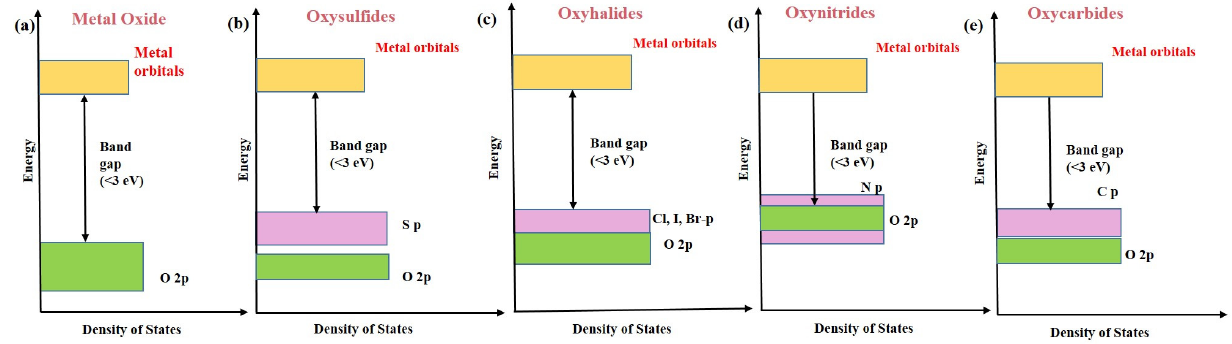
Figure 3. Comparison of the electronic structure of ( a ) metal oxides with ( b ) oxysulfides, ( c ) oxyhalides, ( d ) oxynitrides, and ( e ) oxycarbides photocatalysts [14].